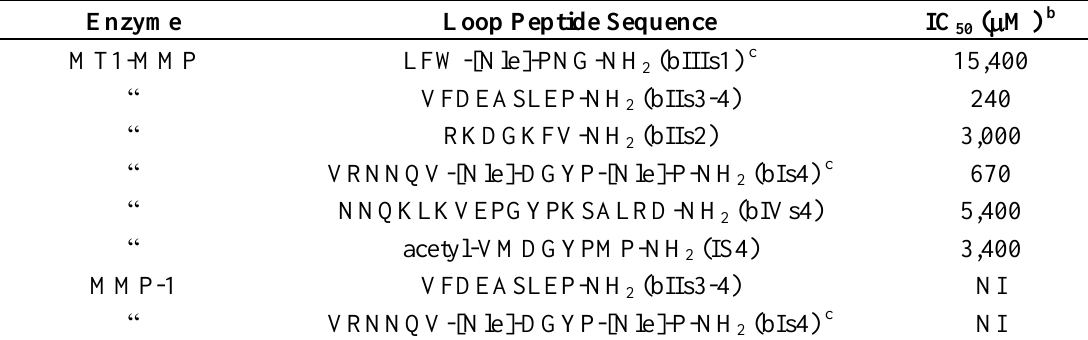
Table 3. Inhibition of MMP Triple-helical Peptidase Activity by MT1-MMP HPX Domain Loop Peptides a